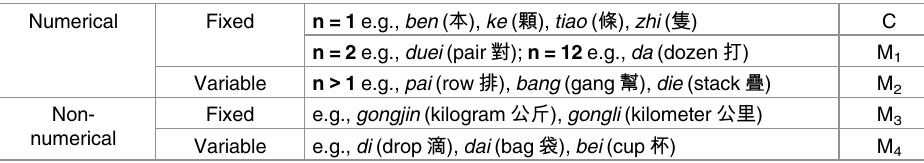
Table 2. Types of mathematical values denoted by C/Ms.